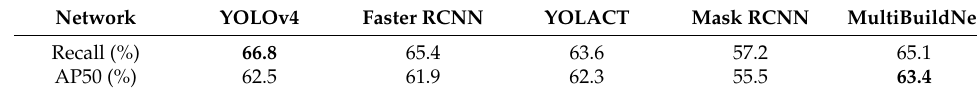
Table 4. Accuracy of building detection on the Massachusetts dataset.